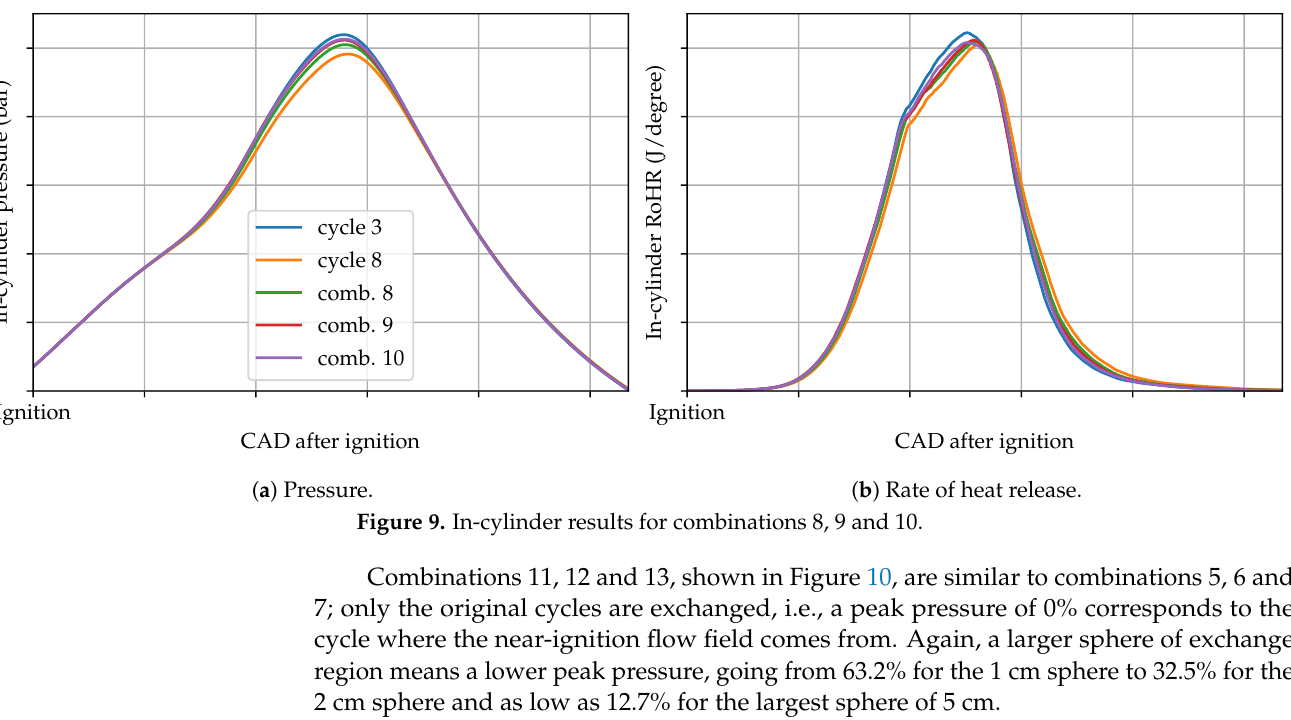
turbulent flame propagation and that most contributions to CCV are due to the flow field inside the 1 cm sphere.